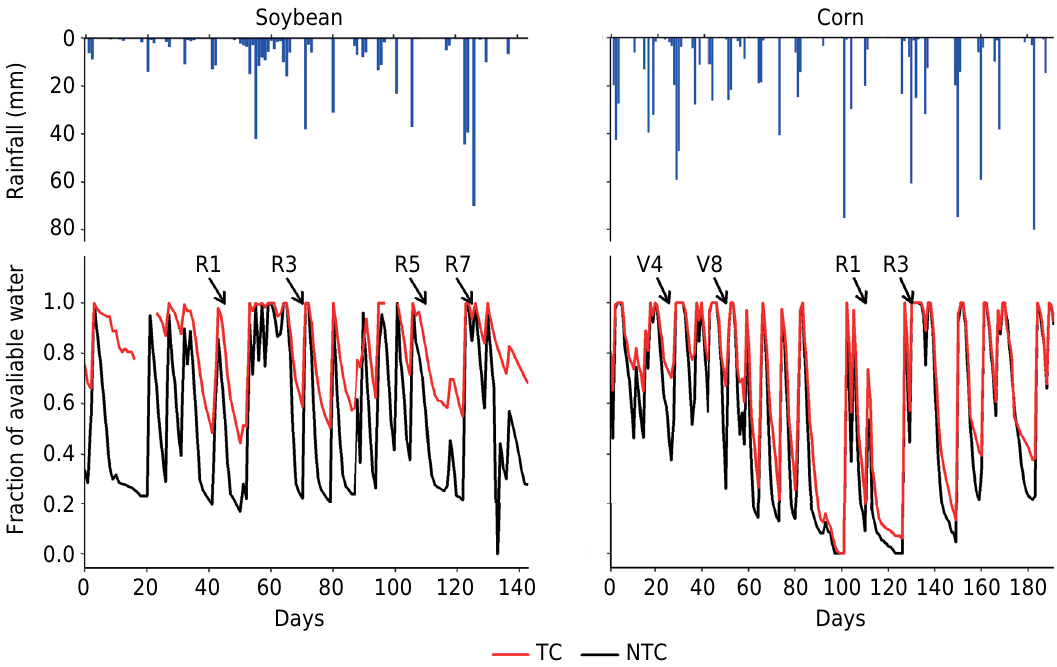
Figure 8. Rainfall and fraction of available water in the rooting zone (0.00-0.30 m) during the corn and soybean